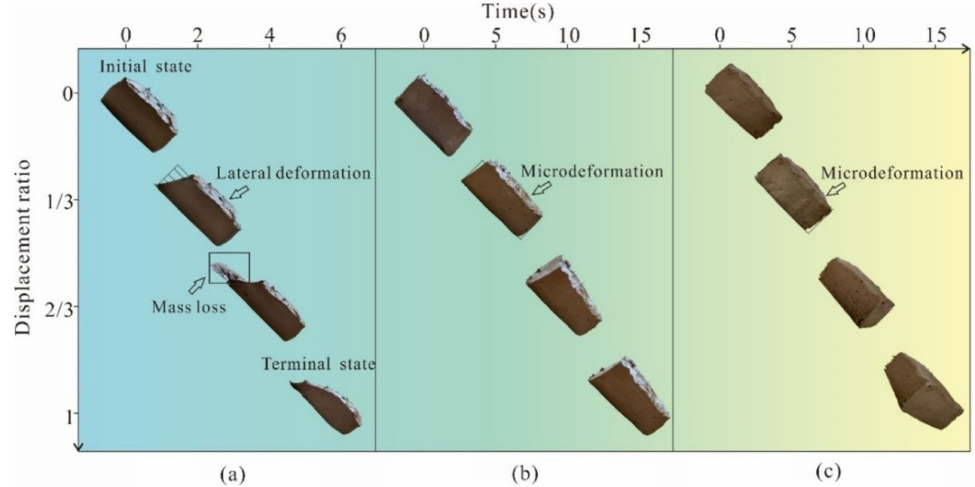
Figure 9. The sliding morphology of ( a ) pure clay, ( b ) fiber-reinforced clay and ( c ) PVAc reinforced clay.